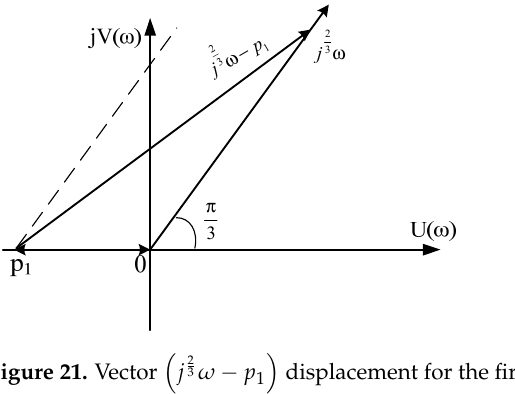
(cid:16) (cid:17) j 2 3 ω − p 1 Figure 21. Vector displacement for the first root when ω (cid:101) ( 0, ∞ ) . (cid:3118) Figure 21. Vector (𝑗 (cid:3119) 𝜔 − 𝑝 (cid:2869) ) displacement for the first root when 𝜔 𝜖 (0,∞) .